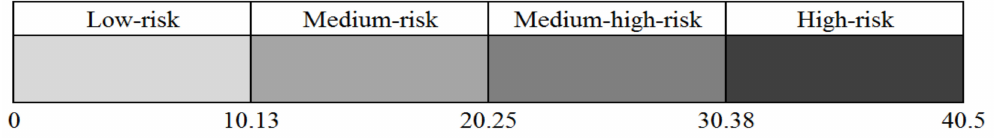
Figure 4. Schematic diagram of the Taiwanese ships risk assessment